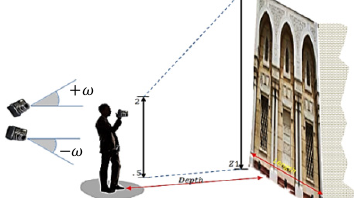
Figure 1. The relation between the camera accessible heights and object height